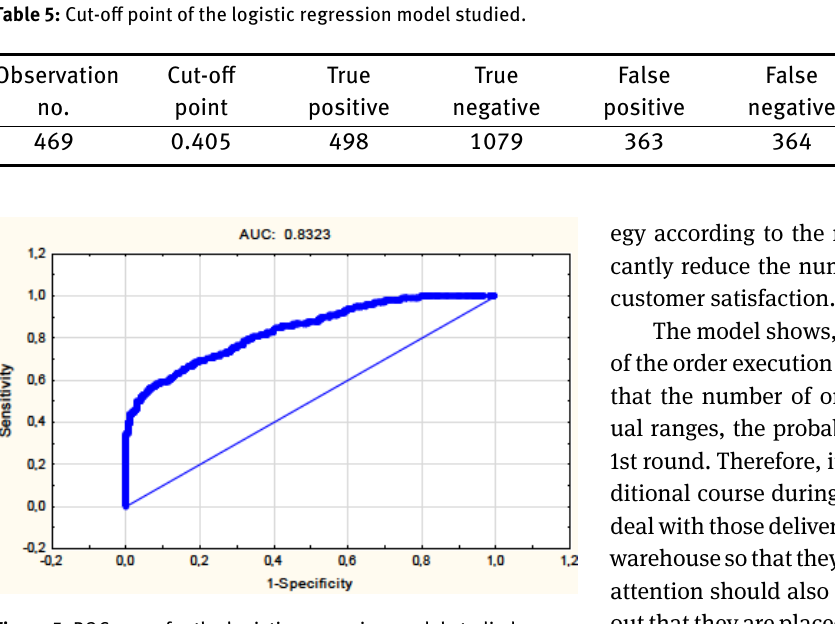
Figure 5: ROC curve for the logistic regression model studied. Table 6: AUC